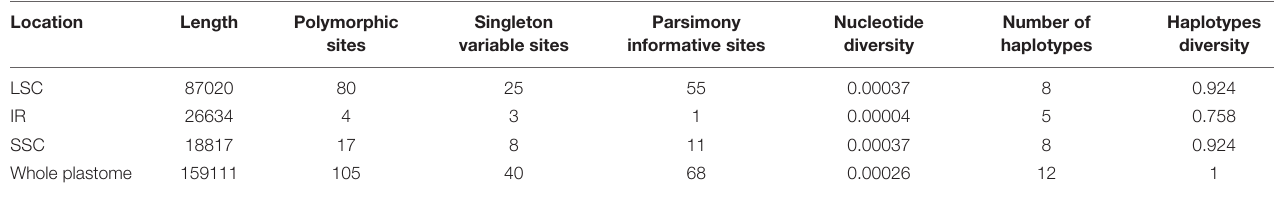
TABLE 3 | Chloroplast genome sequence variable in the B. sinensis